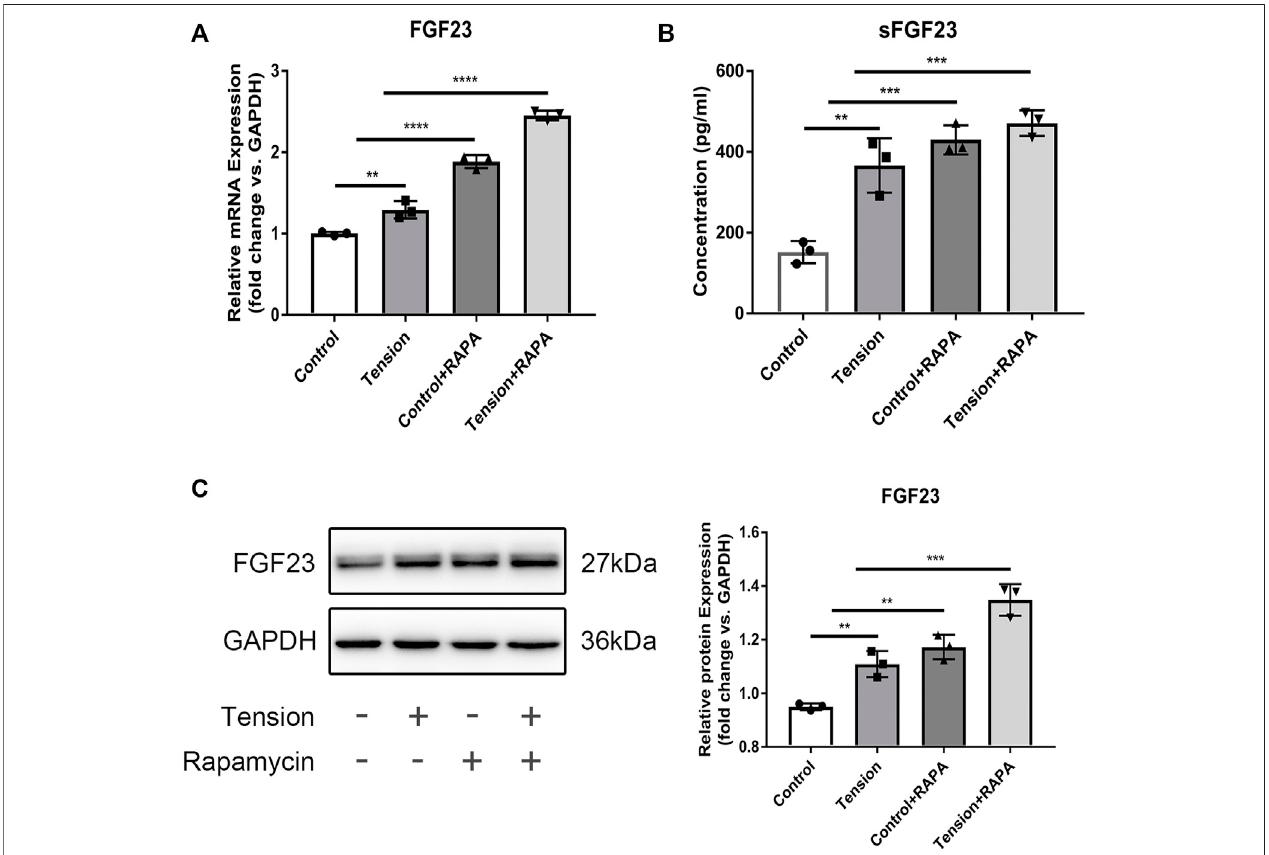
FIGURE 5 | Mechanical tension-iniated autophagy promotes FGF23 secretion. (A) The mRNA expression level of FGF23 MLO-Y4 after mechanical tension was measured by RT-PCR. GAPDH was used for normalization. (B) The expression of soluble FGF23 in the supernatant of MLO-Y4 after mechanical tension was detected by ELISA. (C) Western blot analysis of total protein expression of FGF23. GAPDH was used for normalization. All cell experiments were repeated 3 time and each time they were performed in at least 3 replicate wells. All data were showed as means ± SD. * p ˂ 0.05 vs . control.